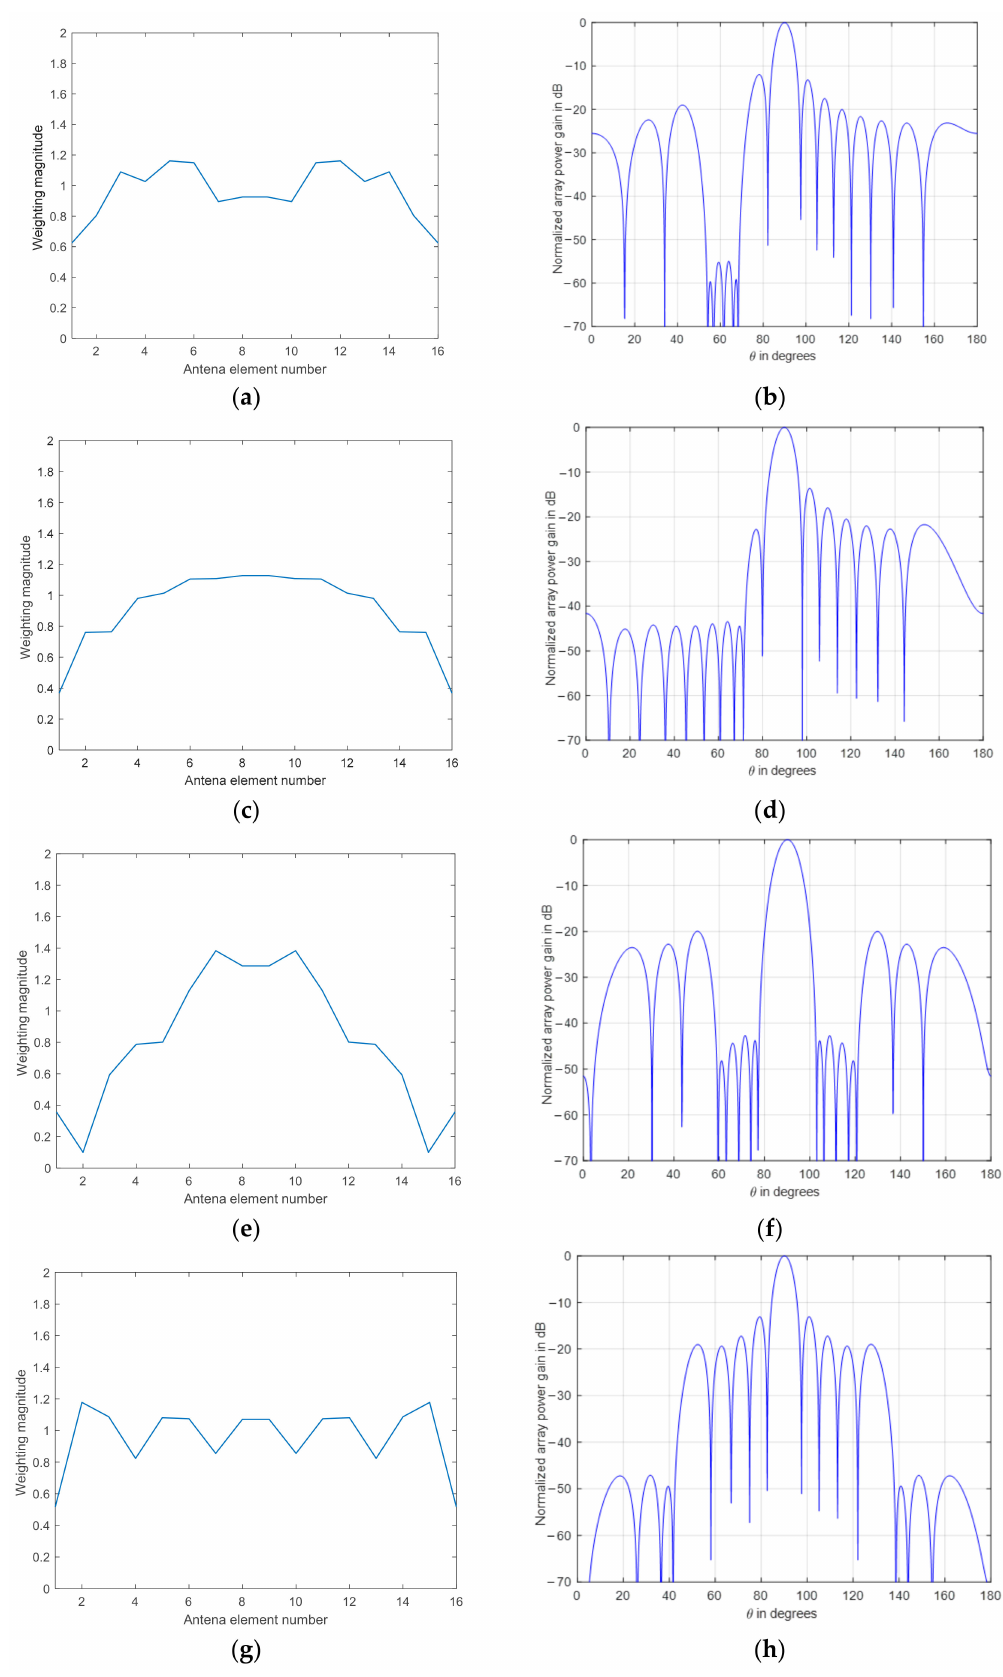
Figure 7. Selective SLL reduction and spatial filtering at various scenarios using 16-element array: ( a , c , e ), and ( g ) are the required weight functions for realizing the power patterns in ( b , d , f ), and ( h ),